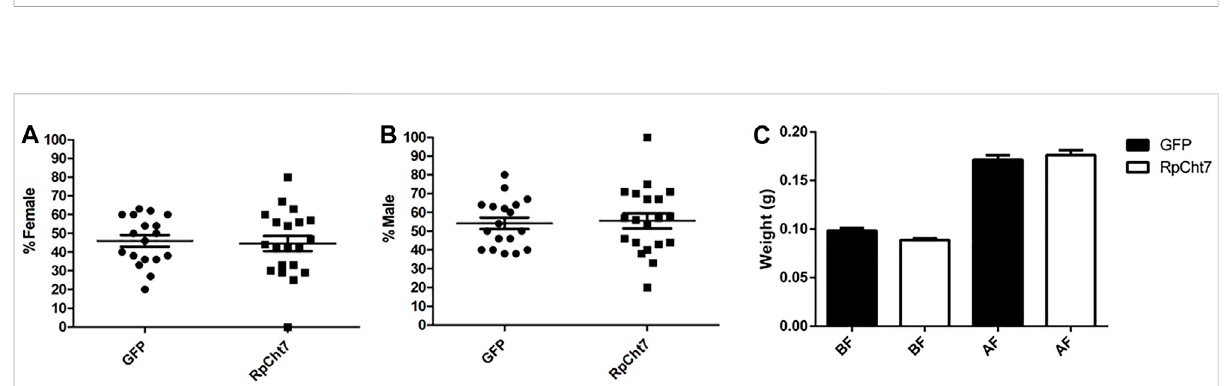
FIGURE 10 Sexratioin R.prolixus adultsafterdsRNA injectionin fi fth-instarnymphs. (A) Percentageoffemales. (B) Percentageofmales.GFP:injectedwith ds GFP ; RpCht7: injected with ds RpCht7 . The experiment was performed 8times with groups of20 – 30insects each. Nosigni fi cant differences were foundbetweenGFPandRpCht7groups( p > 0.05; t -test). (C) Adultinsectweightof R.prolixus injectedwithdsRNAsin fi fth-instarnymphs.BF,before feeding; AF, after feeding. ds GFP : black; ds RpCht7 : White. The experiment was performed 8 times with groups of 15 – 25 insects each. No signi fi cant differences were found between GFP and RpCht7 groups ( p > 0.05; one-way ANOVA –